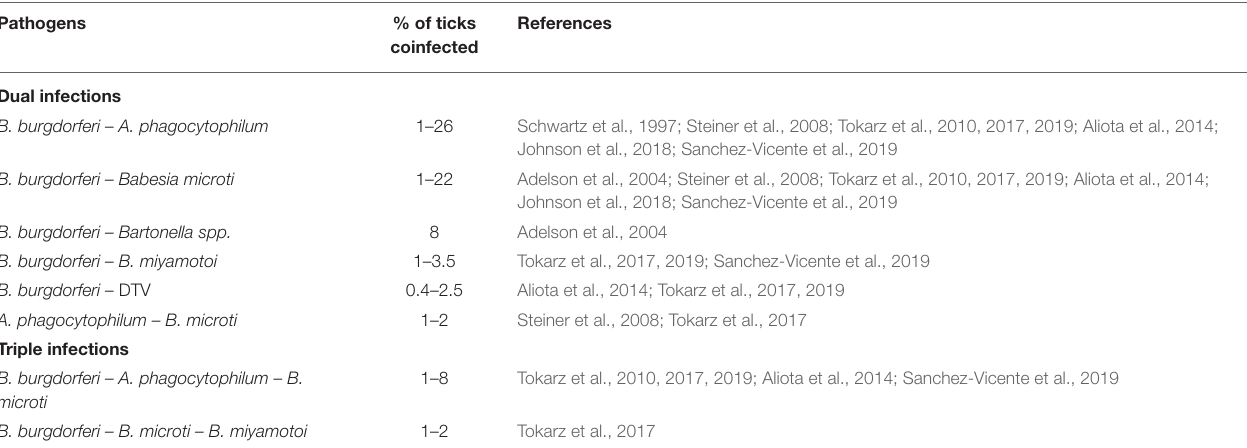
TABLE 2 | Coinfection of I. scapularis with human